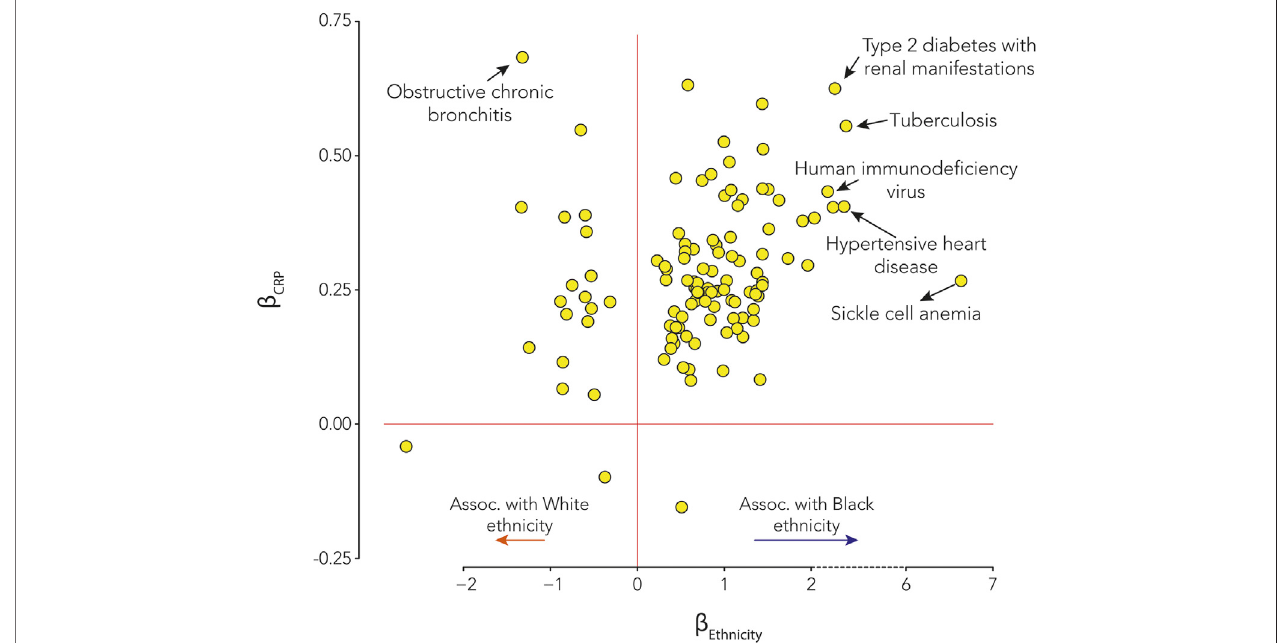
FIGURE 5 | Effects of C-reactive protein (CRP) and ethnicity on disease. Effect sizes for statistically signi fi cant CRP-disease associations ( β CRP , y -axis) and signi fi cant ethnicity-disease associations ( β Ethnicity , x -axis) associations. β Ethnicity > 0 shows diseases that are positively associated with Black ethnicity, and β Ethnicity < 0 shows diseases that are positively associated with White ethnicity. Select disease examples are annotated as shown.